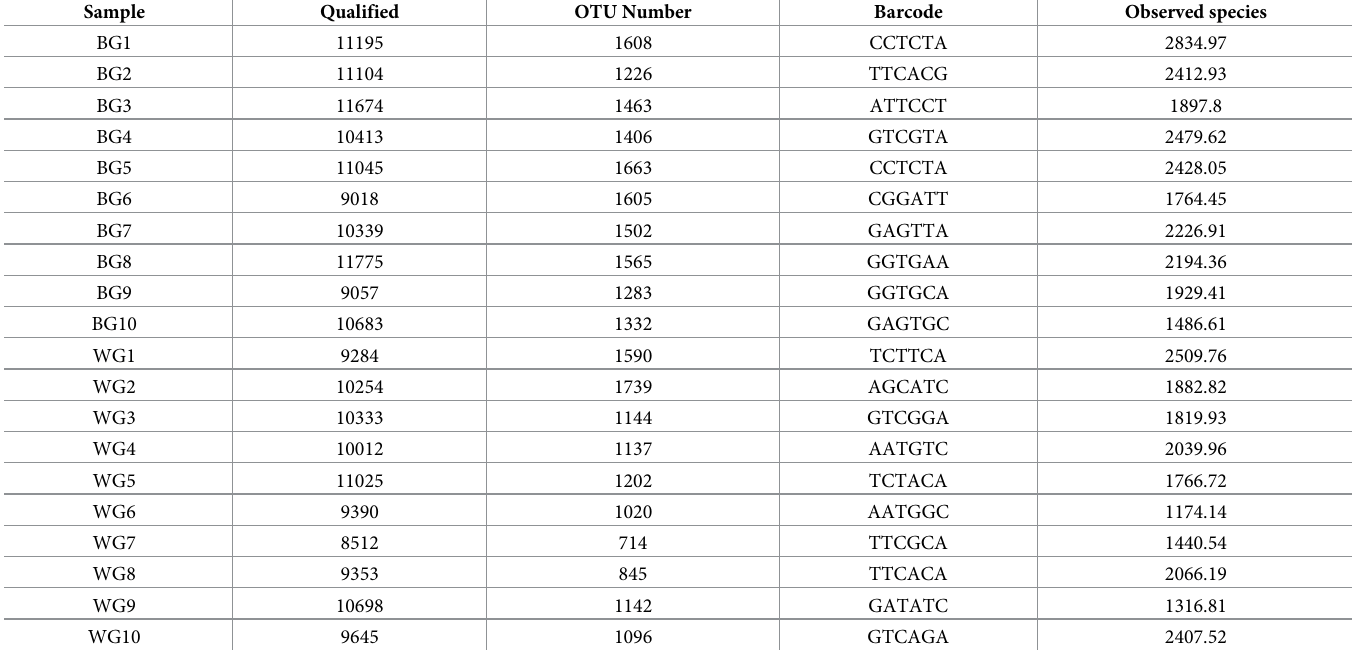
Table 1. Metagenomic sequencing